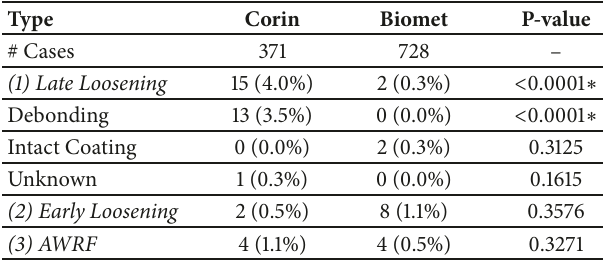
Table 3: Acetabular failures by